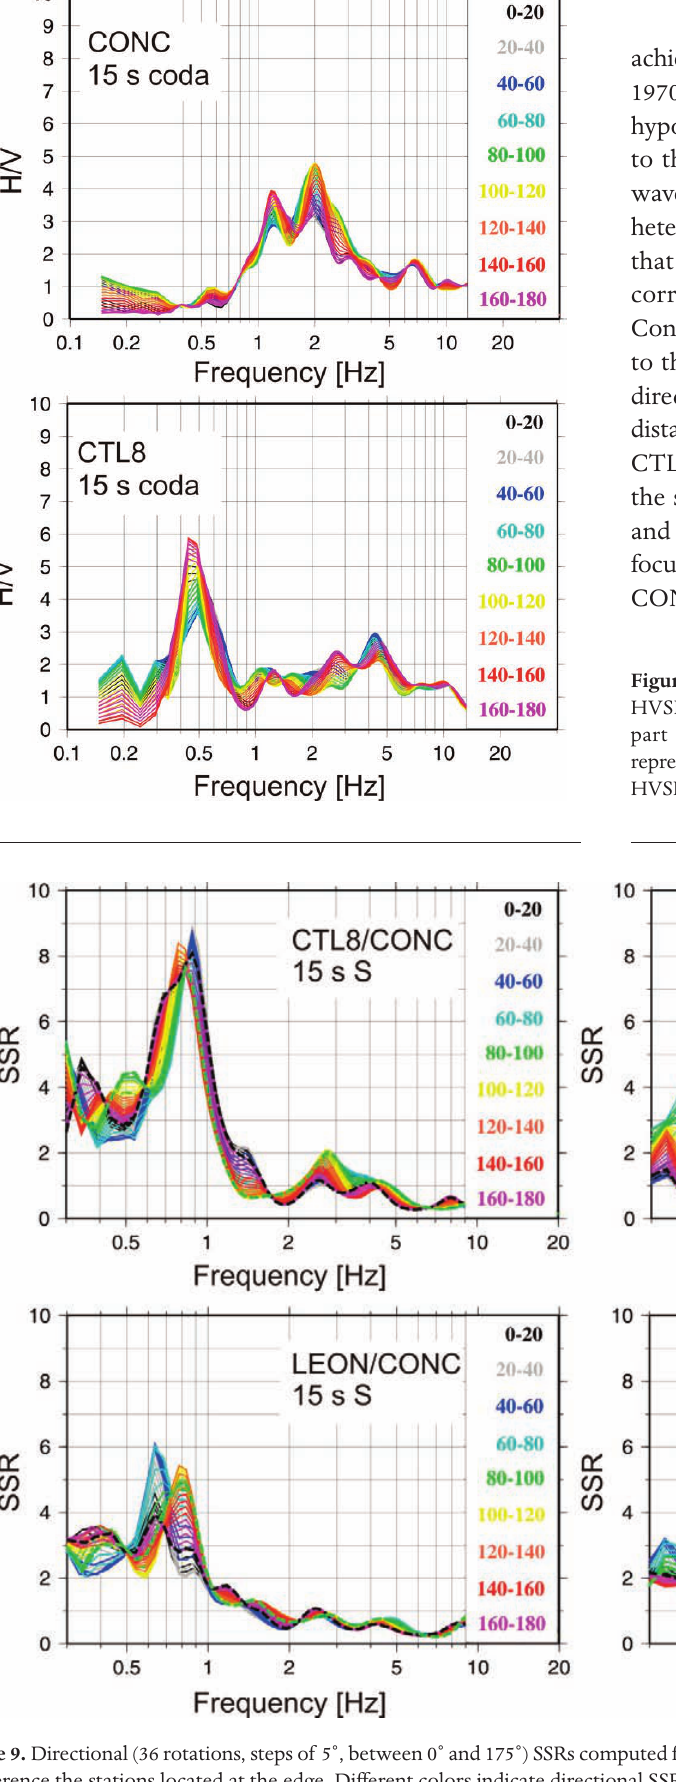
Figure 9. Directional (36 rotations, steps of 5˚, between 0˚ and 175˚) SSRs computed for the stations located in the central part of the Po Plain, considering as reference the stations located at the edge. Different colors indicate directional SSRs grouped by according to 20˚